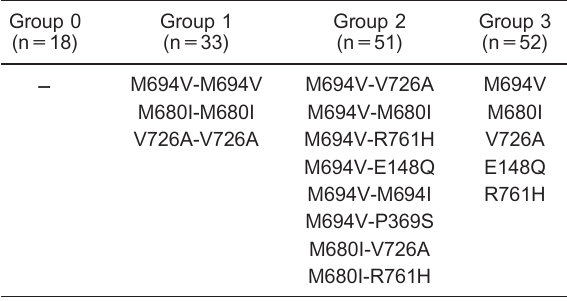
Table 1. Classification of groups according to genetic mutation.